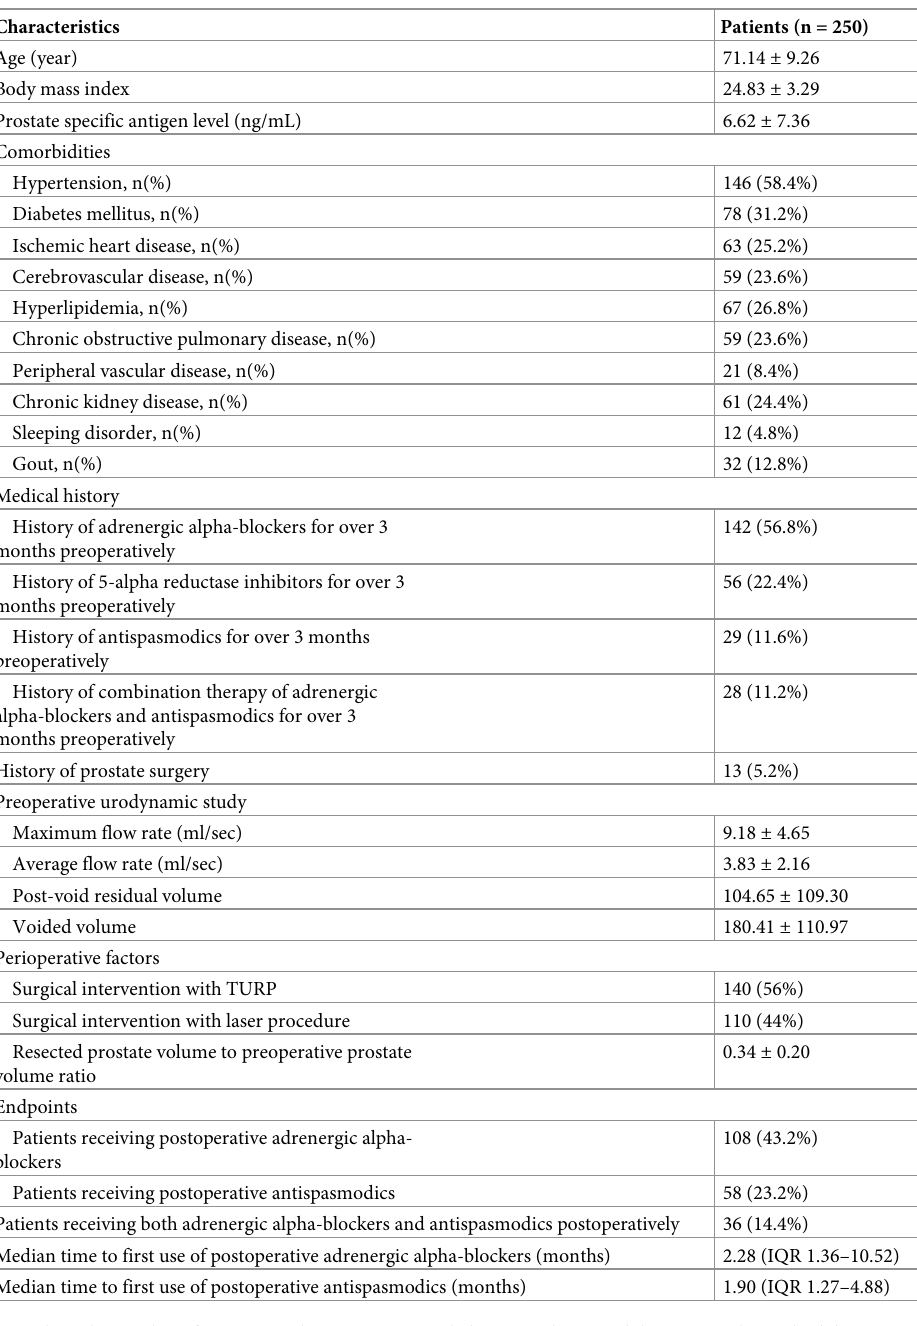
Table 1. Patient